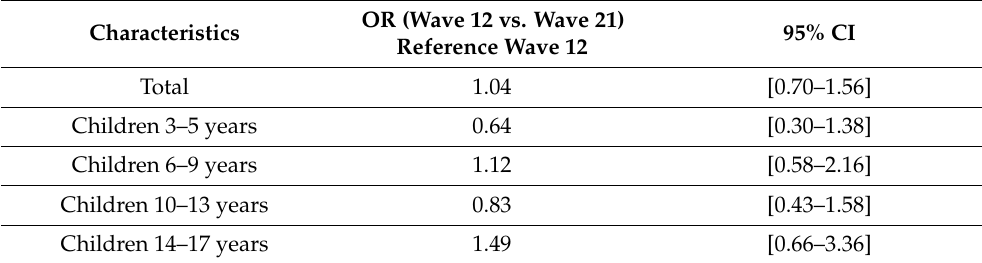
Table A1. Score of family indicator children and adolescents ( n = 217 per wave) for emotional symptoms—odds